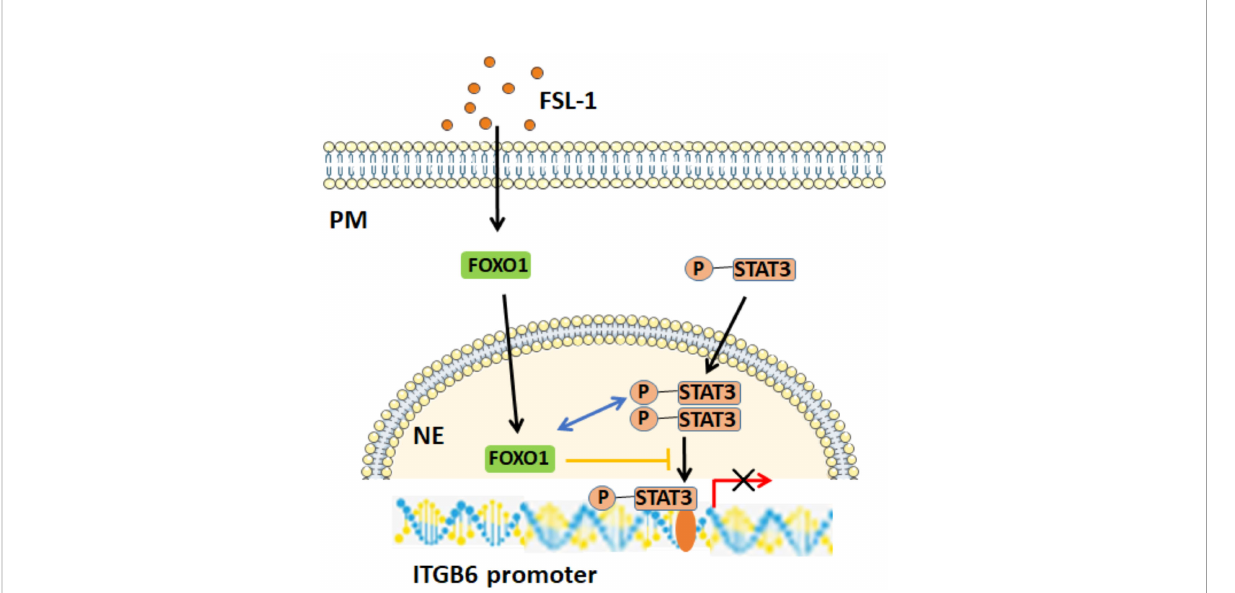
FIGURE 7 Potential mechanism of FOXO1-mediated FSL-1-induced ITGB6 downregulation. FSL-1 increases FOXO1 expression, and FOXO1 interacts with p-STAT3 in the nucleus, prevents the binding of p-STAT3 to the ITGB6 promoter, and consequently inhibits STAT3-mediated ITGB6 transcriptional expression. PM , plasma membrane; NE , nuclear